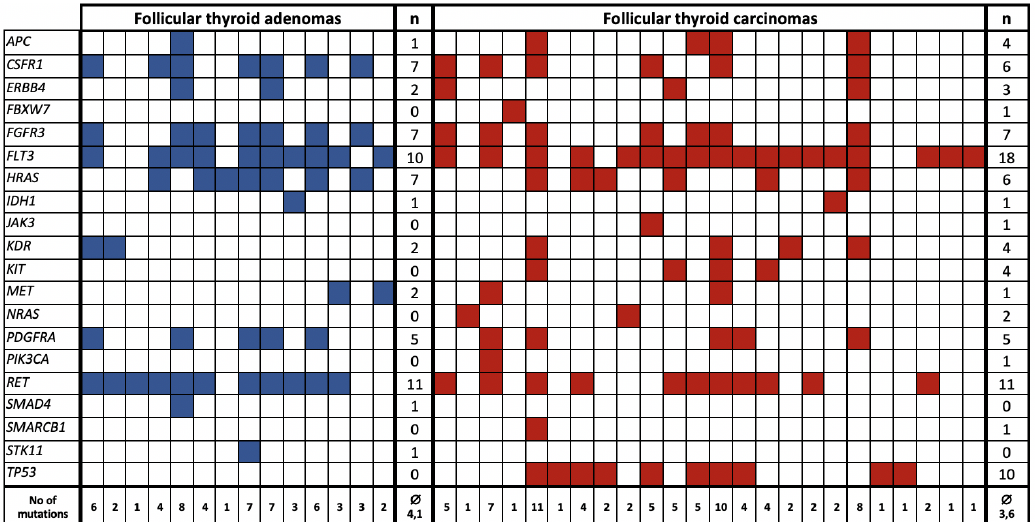
Figure 1. Genetic landscape of follicular thyroid adenomas ( n = 14 / 35)—marked in blue—and follicular thyroid carcinomas ( n = 24 / 35)—marked in red. Columns of the table represent single patients, rows—type of mutation.